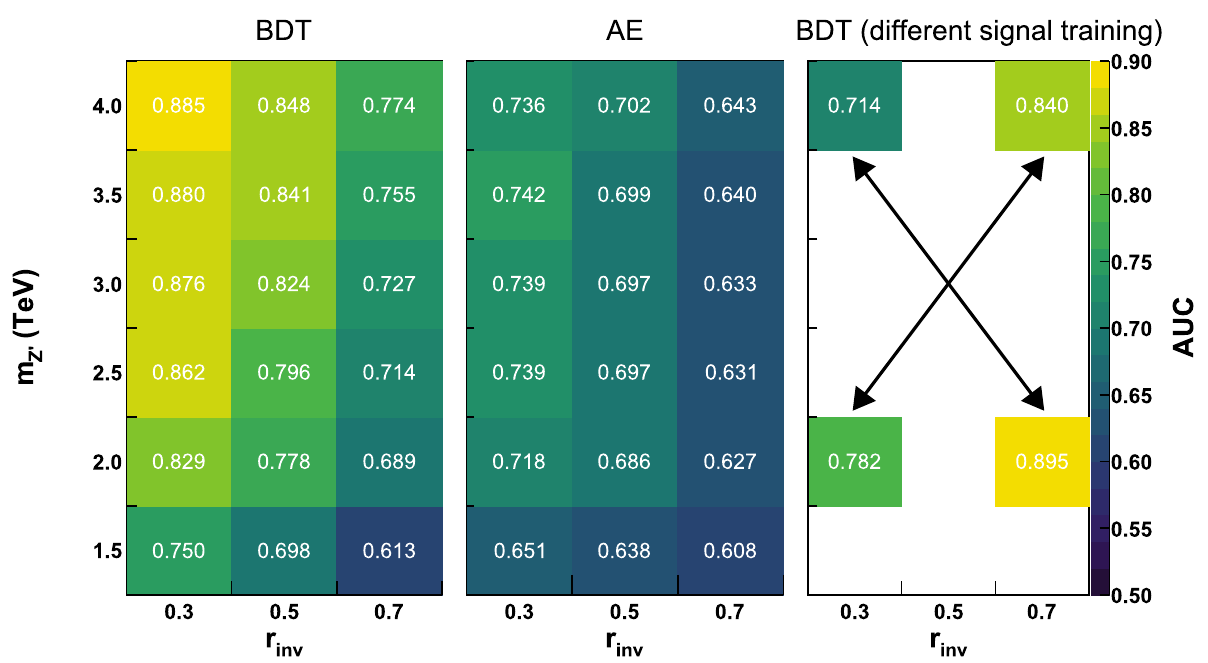
Fig. 52 Left and middle panels: comparison of AUC values from the autoencoder and a BDT trained on a mixture of all signal models with m D = 20GeV. Right panel: AUC values for a BDT trained on a signal with parameters different from the signal used for testing, as indicated